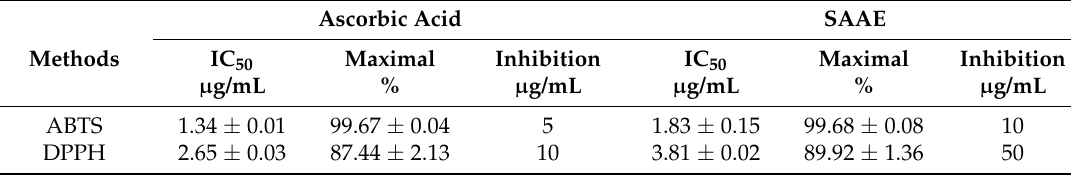
Table 2. IC 50 and maximum activity of the standard antioxidant and of S. adstringens aqueous extract (SAAE) in ABTS and DPPH free-radical